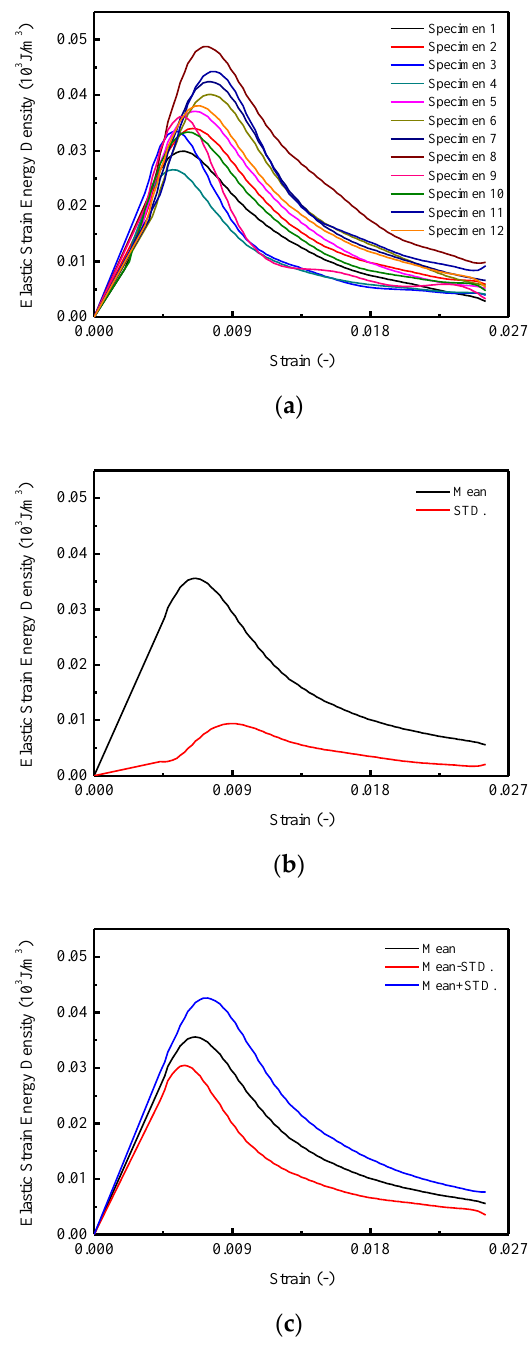
Figure 8. Elastic strain energy of CA mortar specimens: ( a ) Elastic strain energy of specimens; ( b ) Mean and STD for elastic strain energy; ( c ) Mean ± STD for elastic strain energy.